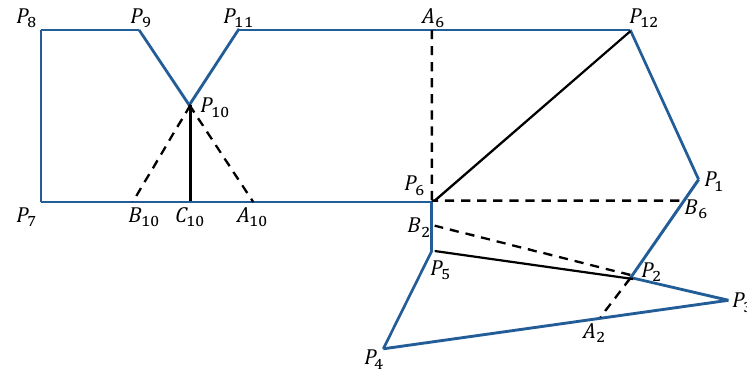
Figure 9. Slice decomposition algorithm.